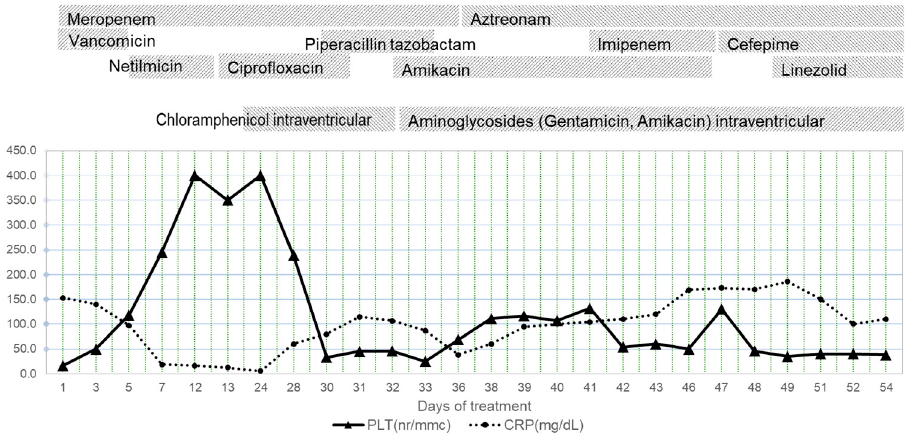
Figure 4. Brain ultrasound on the 30th day of life: cystic cavity (( a ) Frontal coronal plan, ( b ) right parasagittal plan).